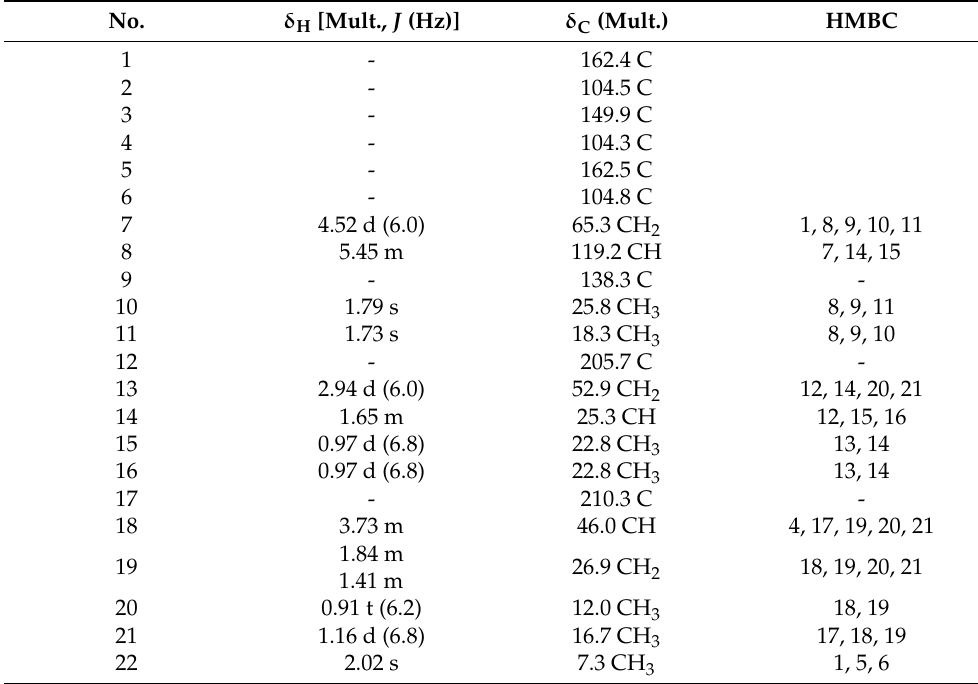
Table 1. NMR spectral data of compound 1 (CDCl 3 , 850 and 214 Hz). No. δ H [Mult., J (Hz)] δ C